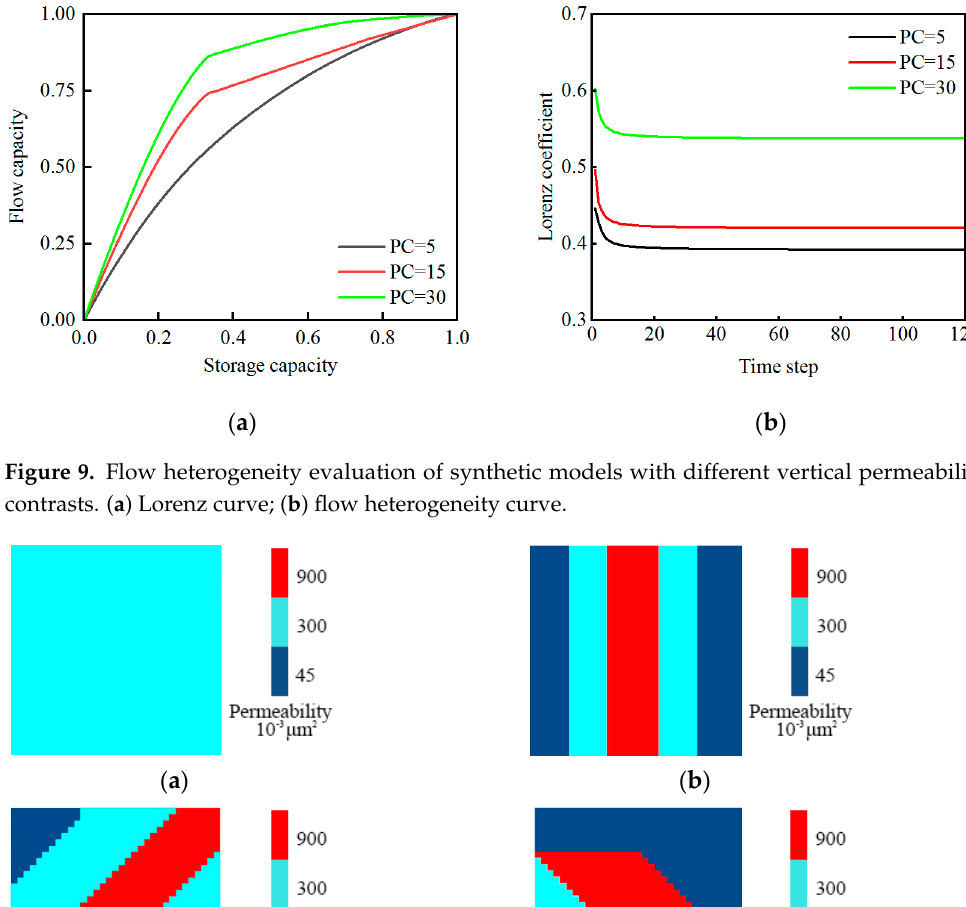
Figure 9. Flow heterogeneity evaluation of synthetic models with different vertical permeability contrasts. ( a ) Lorenz curve; ( b ) flow heterogeneity curve.